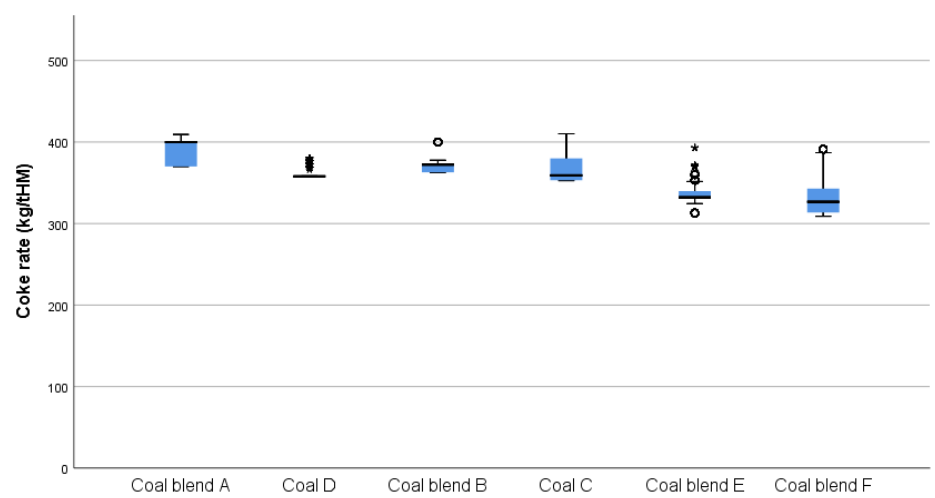
Figure 13. Box plots of the range of coke addition rates for the time periods corresponding to the addition of different coals/coal blends during blast furnace production ( ◦ = high/low potential outliers and * = high/low extreme values).